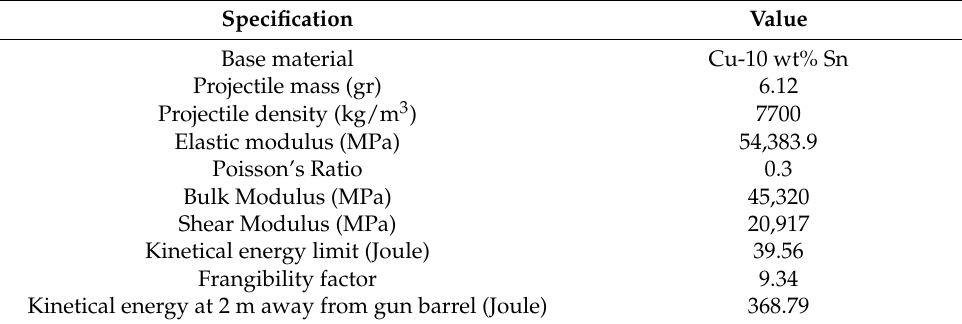
Table 1. AMMO 1 Table 1. AMMO 1 specification.